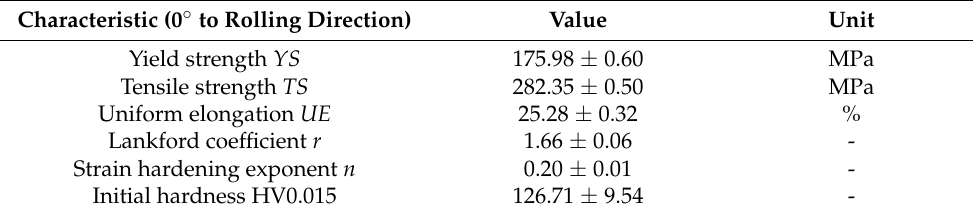
Table 1. Mechanical properties of the investigated material DC04 (1.0338) from tensile test. Characteristic (0 ◦ to Rolling